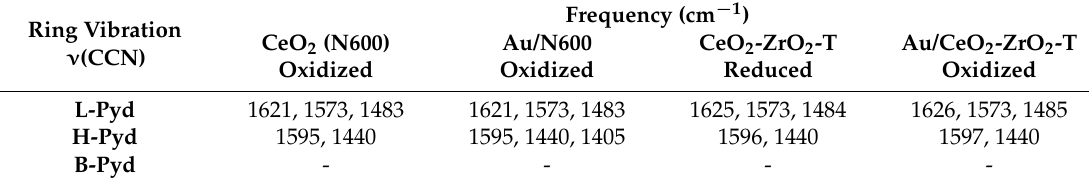
Table 6. Ring vibrational modes of adsorbed pyridine on Au- loaded CeO 2 -and CeO 2 -ZrO 2 -T samples. Ring Vibration